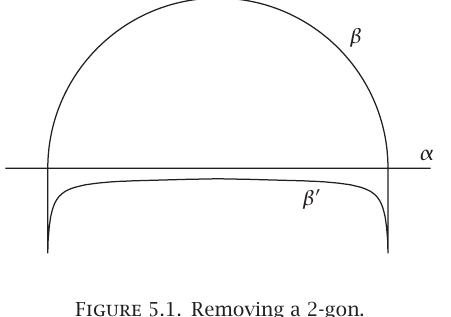
Figure 5.1 . Removing a